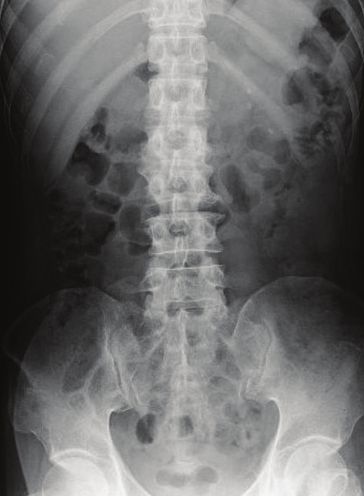
Figure 1: Preoperative abdominal X-ray.